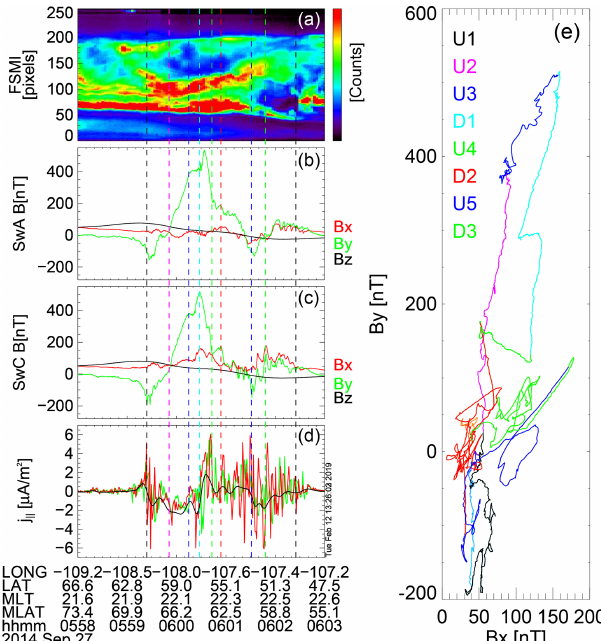
Figure 13. Same panels as in Fig. 4. The vertical lines indicate indi- vidual FACs, e.g., first black, magenta, and blue intervals, or larger intervals with small-scale FAC signatures, e.g., red, second blue, or second green